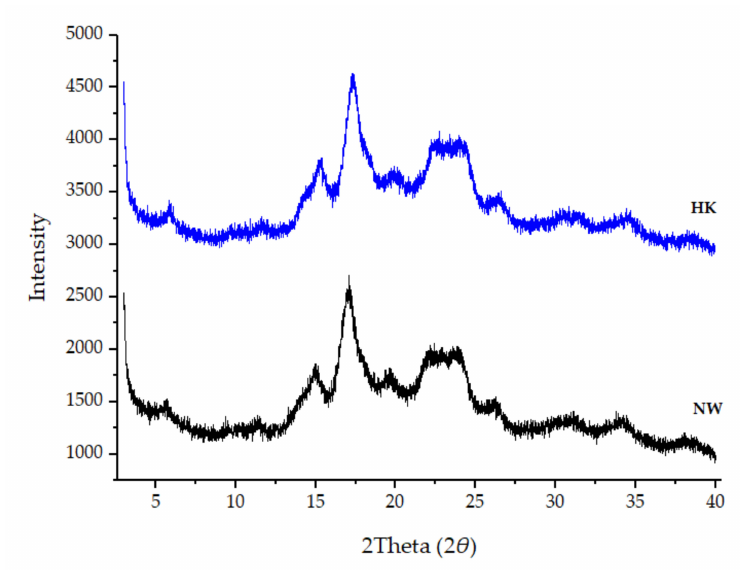
Figure 4. X-ray diffraction pattern of HK and NW starch granules.